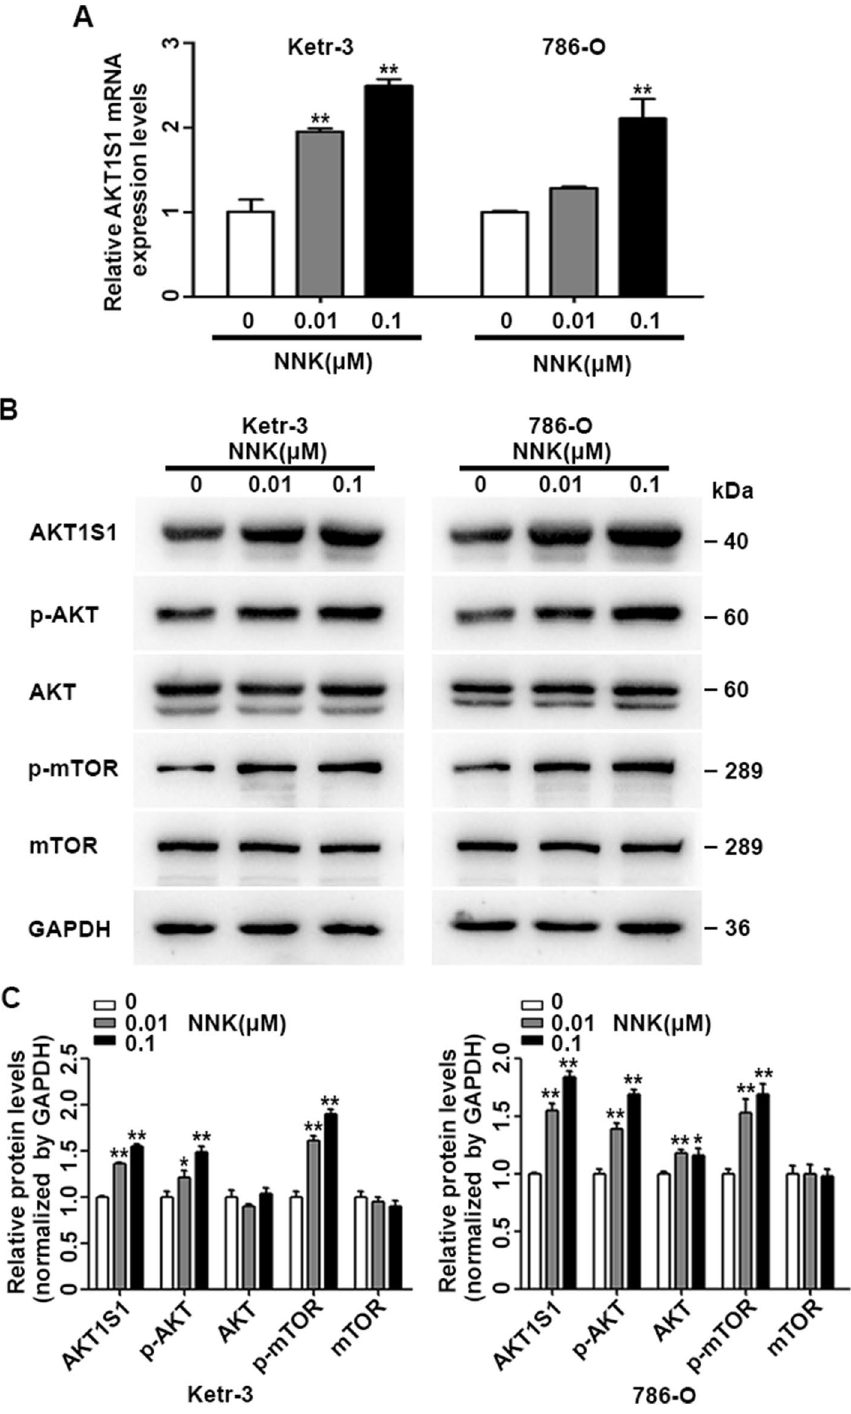
Figure 7. NNK Exposure promoted AKT1S1 expression and activated AKT/mTOR signaling pathway. ( A ) Real time PCR assay showed the relative mRNA expression levels of AKT1S1 in Ketr-3 and 786-O cells exposed